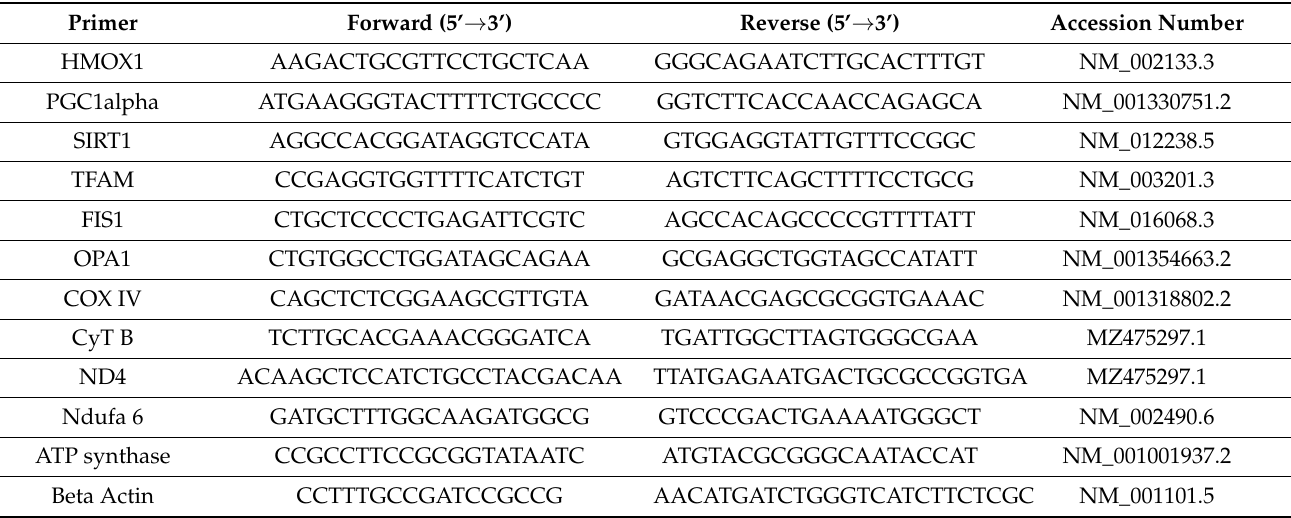
Table 1. Primer sequences used for qPCR